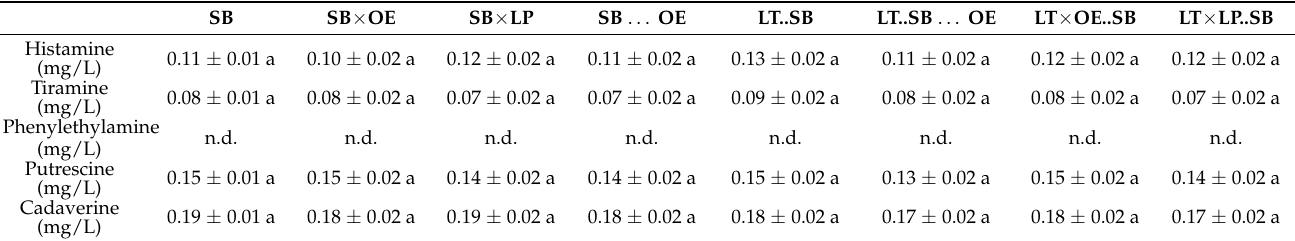
Table 4. Final biogenic amines analysis of fermentations from Tempranillo red grapes: S. bayanus alone (SB); coinoculation of S. bayanus and O. oeni (SB × OE); coinoculation of S. bayanus and L. plantarum (SB × LP); sequential fermentation with S. bayanus and O. oeni after alcoholic fermentation (SB . . . OE); sequential fermentation with S. bayanus and L. thermotolerans during alcoholic fermentation (LT..SB); sequential fermentation with S. bayanus and L. thermotolerans during alcoholic fermentation, followed by O. oeni after alcoholic fermentation (LT..SB . . . OE); coinoculation of L. thermotolerans and O. oeni, followed by S. bayanus (LT × OE..SB); and coinoculation of L. thermotolerans and L. plantarum, followed by S. bayanus (LT ×